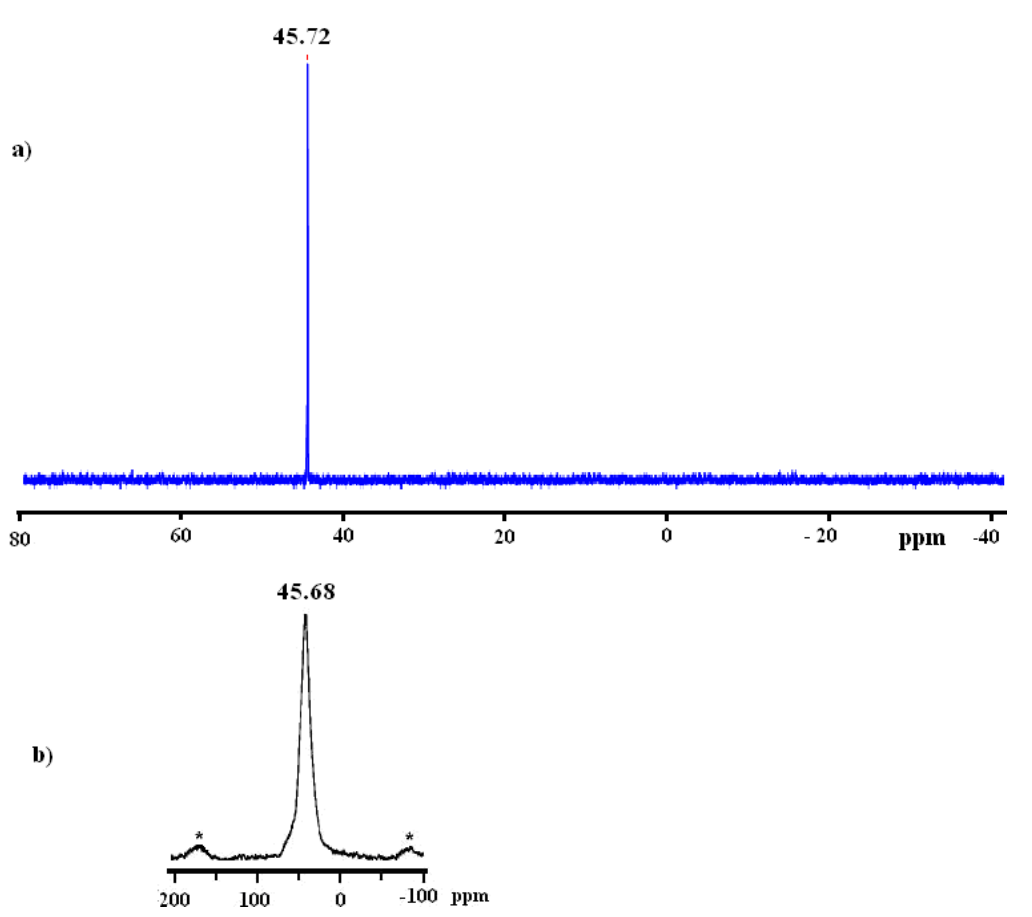
spectrum of X2 xerogel after